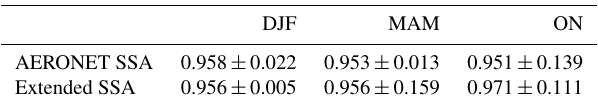
Table 3. Comparison of extended SSA over the ocean with AERONET SSA from MCOH. DJF MAM